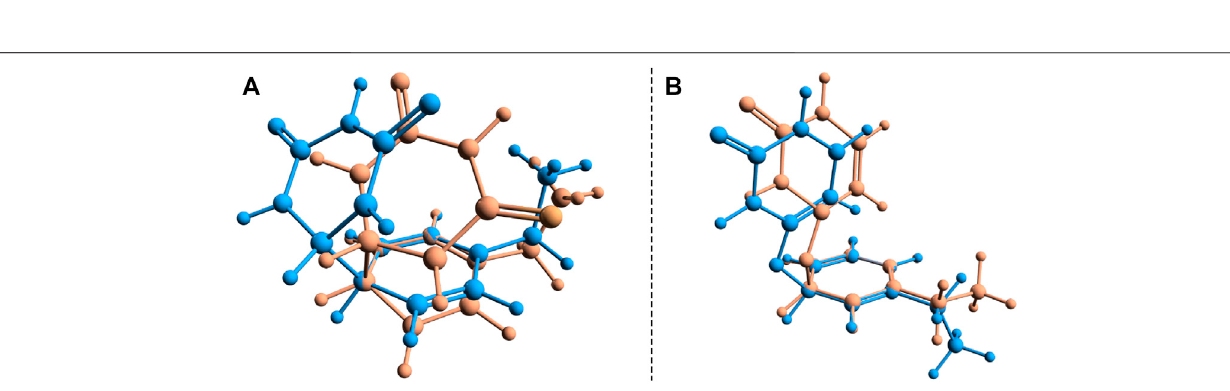
FIGURE7| Structuraldeviationforthetwo(S 0 ⊗ S 1 ) a and(S 0 ⊗ S 1 ) b conicalintersectionpointsfoundforthebenzene – uracil(B – U)binarycomplexcomputedwiththe standard (orange) and spin- fl ip (blue) TDDFT